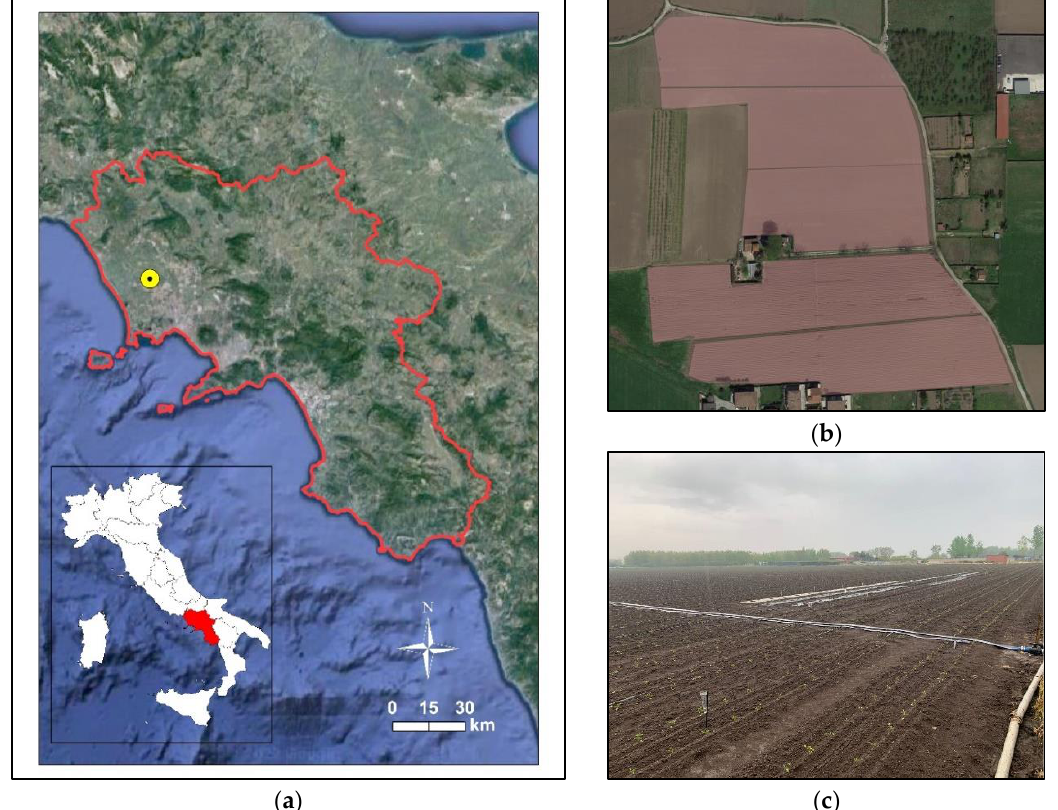
Figure 1. Study area: ( a ) Campania region (red boundaries) and location of the site of interest (yellow circle); ( b ) Plots of the farm of interest; ( c ) Irrigation sectors.